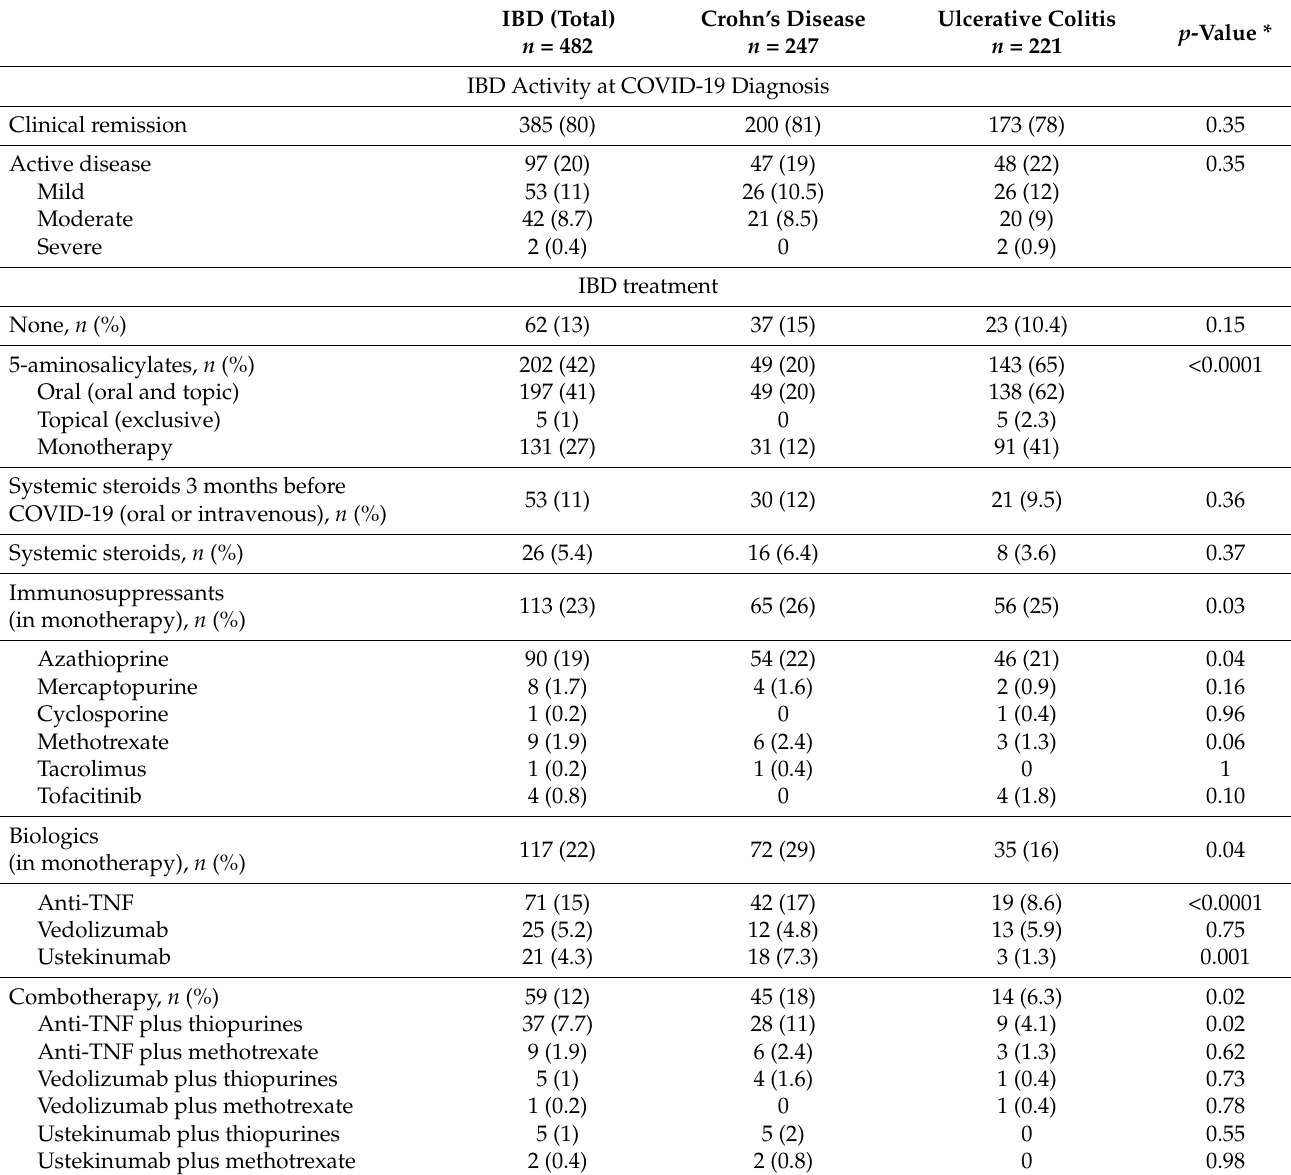
Table 2. Inflammatory bowel disease activity and treatment at time of COVID-19